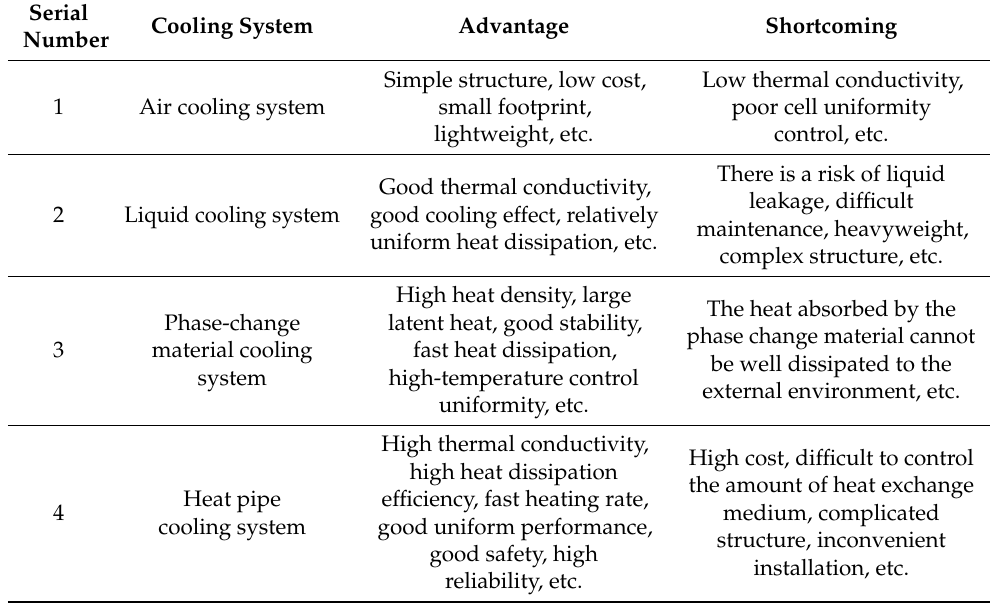
Table 1. Features of the four cooling